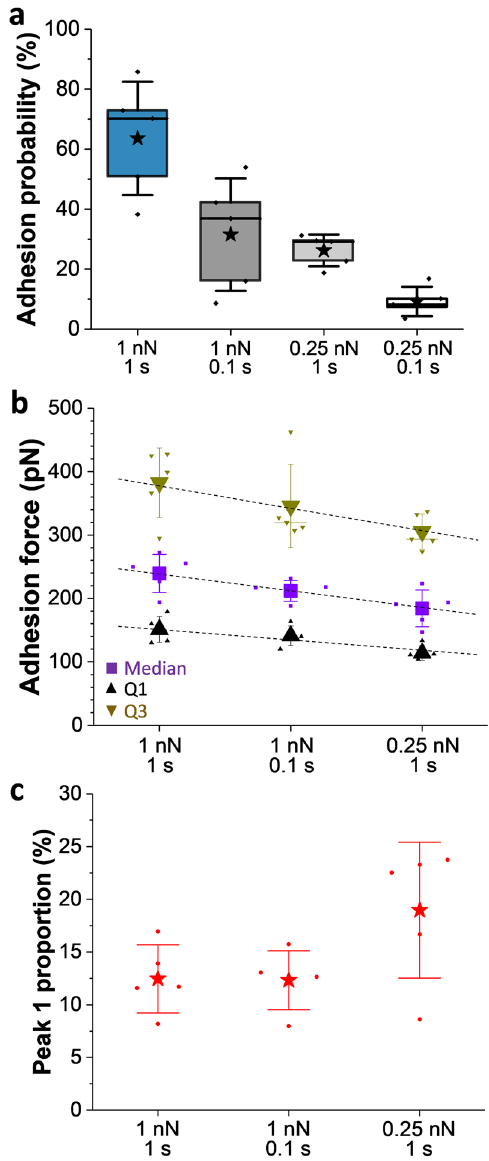
Fig. 3 The role of applied force and probing time in cell – cell adhesion. a Box plots of the adhesion probability between MAT a and MAT α cells, pretreated with pheromones, recorded under different applied forces (1 or 0.25 nN) and with different probing times during force – distance curve measurements (1 or 0.1 s). Stars are the mean values, lines the medians, boxes the 25 – 75% quartiles, and whiskers the SD from N = 5 independent cell pairs. b Scatter plots, overlapped with data points, of the adhesion forces reached at diverse quartiles (Q1: 25%, median: 50% and Q3: 75% of the adhesive population) as a function of the applied force and probing time used to record the force – distance curves between MAT a and MAT α cells. Error bars are the SD from N = 6 independent cell pairs. Dashed lines are a guide for the eye. c Proportion of the fi rst peak identi fi ed in Fig. 2c (vs the total adhesive population) as a function of the same parameters. Error bars are the SD from N = 5 independent cell